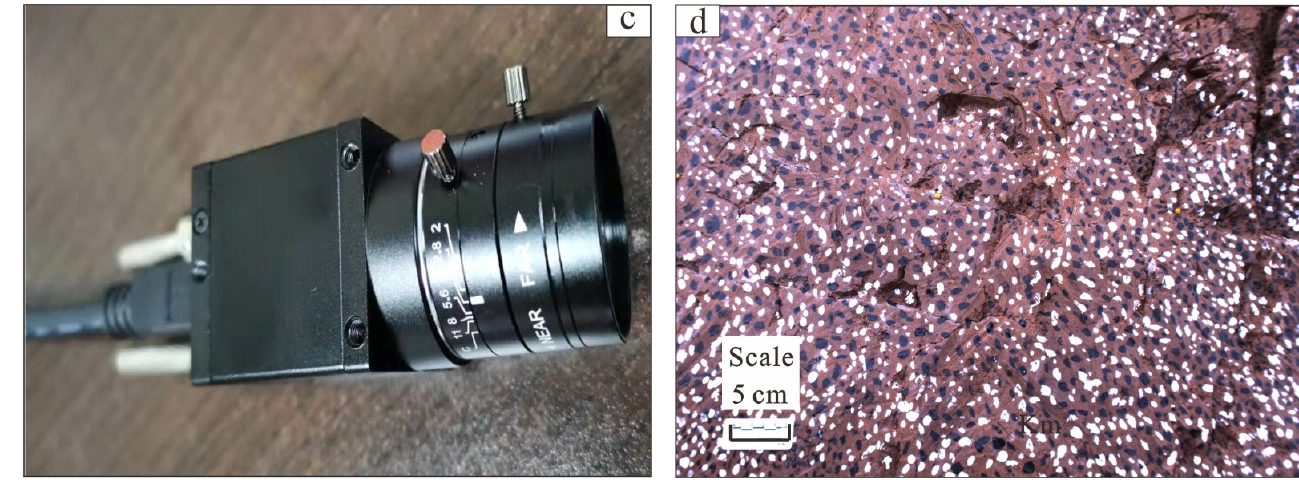
Figure 5. The layout of the test showing ( a ) the establishment of the experimental system; ( b ) the artificial rainfall simulator; ( c ) the image acquisition equipment; and ( d ) the image acquisition results (captured by camera F1 in ( a )).